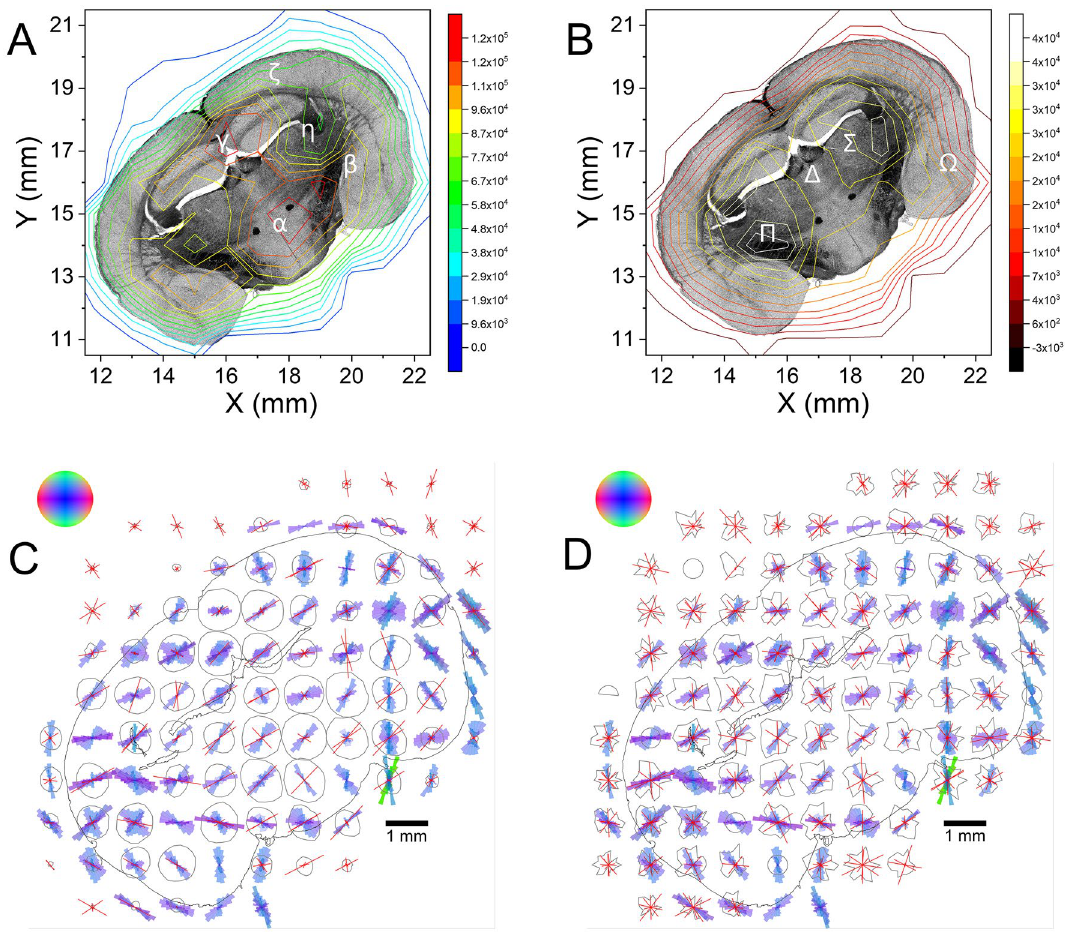
Figure 6. ( A ) The contour lines of the SANS dark-field map in the Porod regime, registered on top of the 3D-PLI transmittance image. α (red + orange lines): lower-central diencephalon zone; β (orange + yellow lines): Amg, opt and ic; γ (red + orange lines): area of cc and hi; ζ (green lines near periphery): cortex. η (green lines): fi, ec and CPu. ( B ) The contour lines of the MBPI map, registered on top of the 3D-PLI transmittance image. Π (white line): fi and CPu; Σ (yellow line): entire η-region of dark-field map, e.g. area of fi, ec and CPu; ∆ (bridging area): cc, sm, fr and mt; Ω (red lines): cortex, Amg and opt. ( C )–( D ) Superimposed map of combined azimuthal intensity profiles (gray fingerprints) and the extracted peaks (red bars) in Porod regime and in Bragg regime on top of the 3D histograms of cumulative 769 × 769 PLI vector data in each square millimeter (cf. Fig 5D). The lengths of the bars indicate the peak prominence i.e. the single peak amplitude divided by the amplitude of the whole 360° intensity profile. The standard RGB color legend (red=horizontal, green=vertical, blue=perpendicular) on the top left reflects the fiber directions in the PLI 3D vector histograms. The location of the brain section is delineated by the black